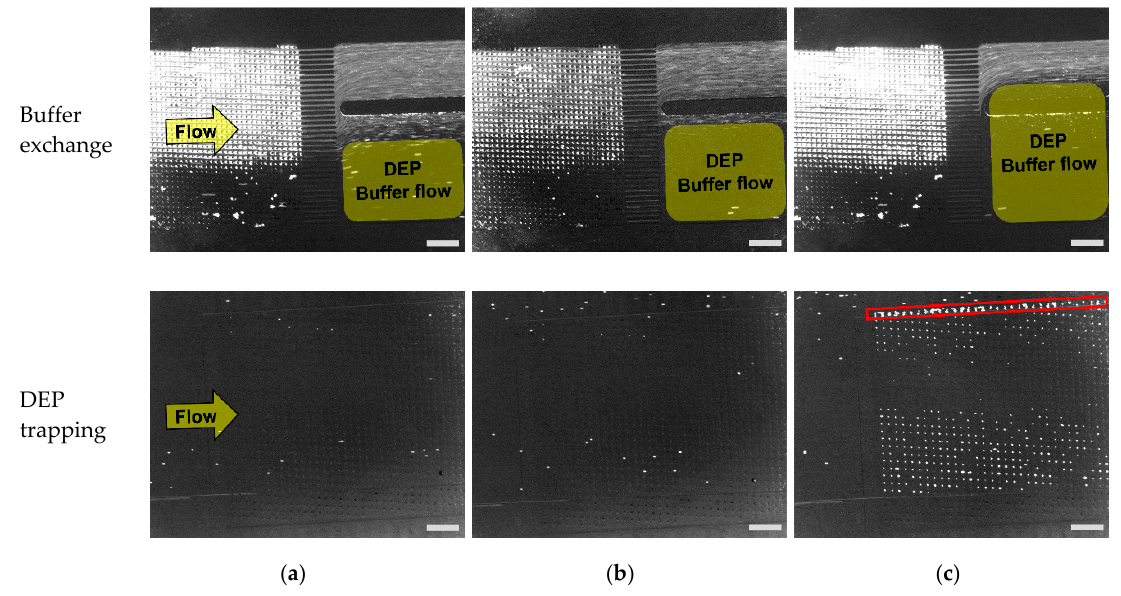
Figure 7. Buffer exchange in the DLD module (above), and the trapping of PC3 cells in a microwell array (below) for various Inlet 2 flow rates, scale bar: 500 μ m. PC3 cells: stained with CellTrace™ Calcein Red-Orange fluorescent dye (emission wavelength: 590 nm). Microbeads: Fluoresbrite ® YO carboxylate microspheres (emission wavelength: 546 nm). ( a ) Flow rate: 1.5 μ L/min; ( b ) Flow rate: 2 μ L/min; ( c ) Flow rate: 2.5 μ L/min